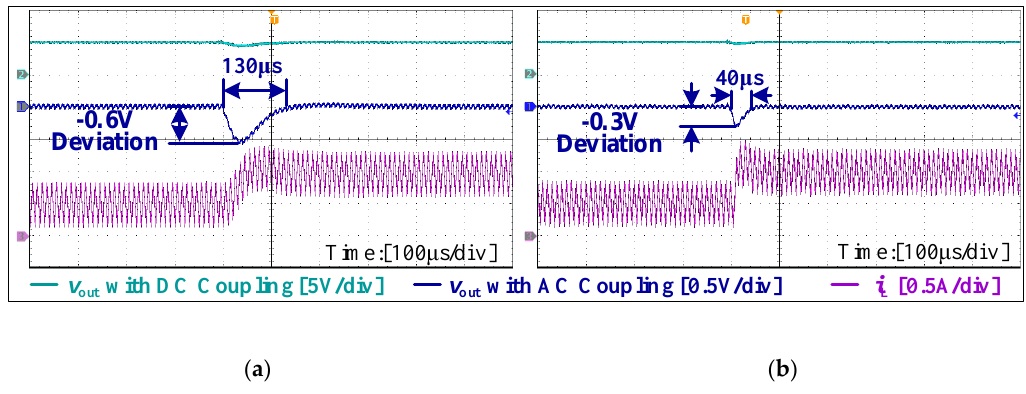
Figure 19. Transient voltage and current when R steps from 10 to 5 Ω: ( a ) Digital current mode control with PID compensation and ( b ) DPVP control.